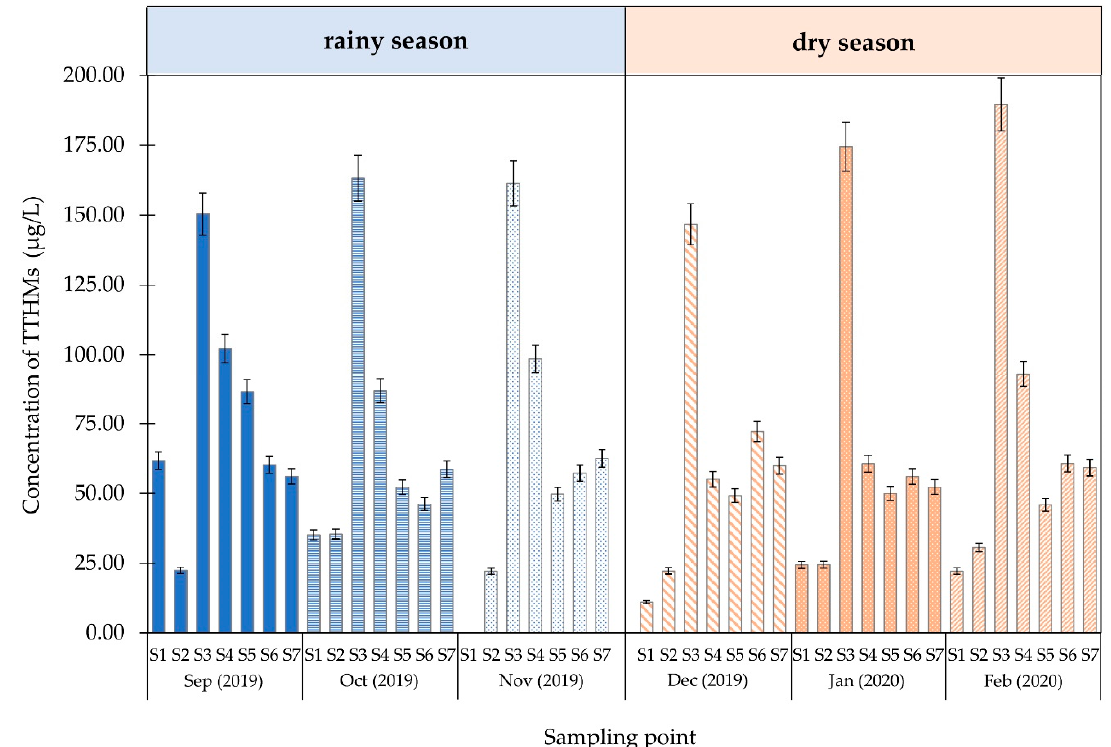
Figure 7. TTHM concentration of water in Chiang Mai, Thailand.